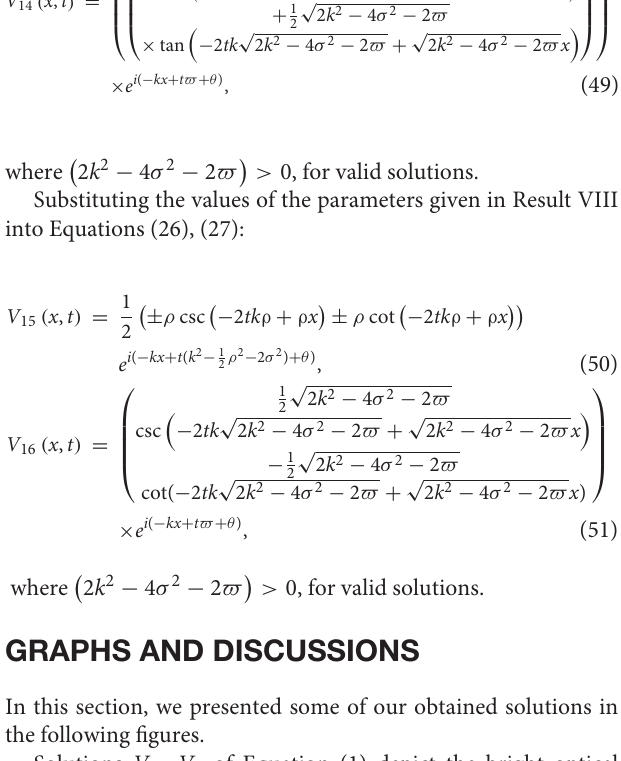
solutions. Figure 2 represents the 3D surface of the dark optical soliton solution of Equation (38) with a contour plot for given parametric values ρ 0.5, θ 0.5, σ 0.5, k 0.5. = = = = Figures 3 , 4 represent the singular and combined singular soliton solutions of Equation (1), obtained from solutions of V 8 and V 12 [Equations (38), (47)] for ρ 0.065, θ 1, σ = = = 0.09, k 0.095 and ̟ 0.05, θ 5, σ 0.05, k 0.09. = = = = = Solutions V 13 , V 14 , V 15 , V 16 of Equation (1) represent the singular periodic wave solutions. Figure 5 illustrates the 3D surface of the singular periodic wave solution of Equation (50) with a contour plot for given parametric values ρ 2.5, θ = = 0.2, σ 0.2, k 7.5. For convenience, some other figures are = = not